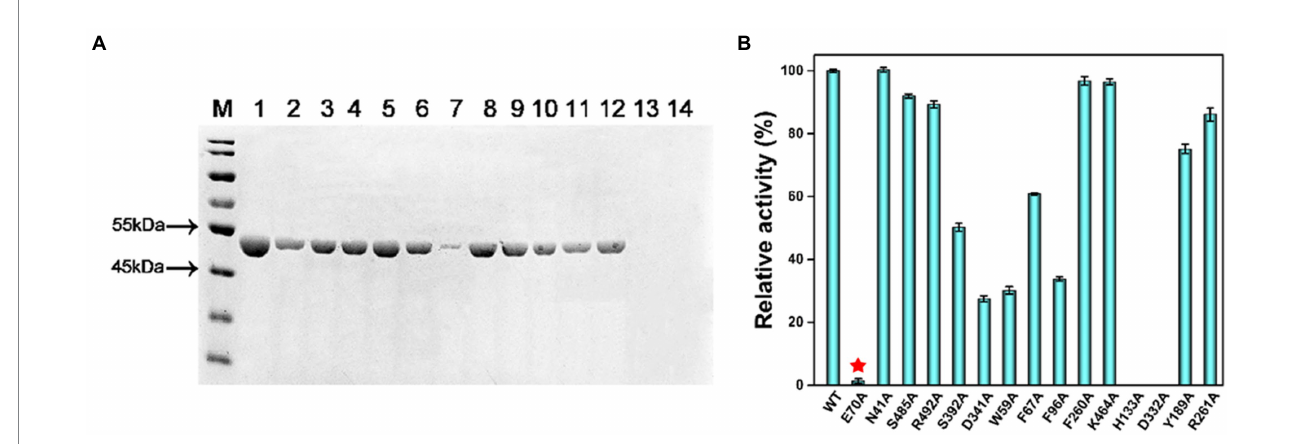
FIGURE 2 (A) Sodium dodecane sulfate–polyacrylamide gel electrophoresis (SDS-PAGE) was used to analyze samples of the variants for their substrate-binding residues. M, protein marker; Lane 1, wild-type MlrC; Lane 2, E70A; Lane 3, N41A; Lane 4, S485A; Lane 5, R492A; Lane 6, S392A; Lane 7, D341A; Lane 8, W59A; Lane 9, F67A; Lane 10, F96A; Lane 11, F260A; Lane 12, K464A; Lane 13, H133A; and Lane 14, D332A. (B) Hydrolytic activities of MlrC and its variants using linearized MC-LR as a substrate. Activities of MlrC and its variants were measured using a linearized MC-LR concentration of 0.25 mg L − 1 and an enzyme concentration of 0.12 mg L − 1 . The amount of Adda produced was monitored by HPLC analysis. The activities of the variants were compared with wild-type